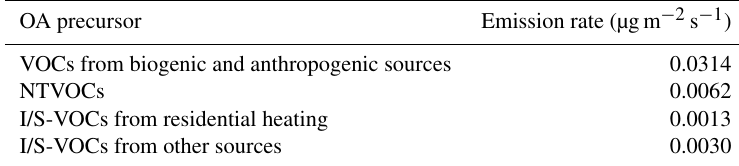
Table 1. Emission rates of OA precursors averaged temporally and over the Mediterranean